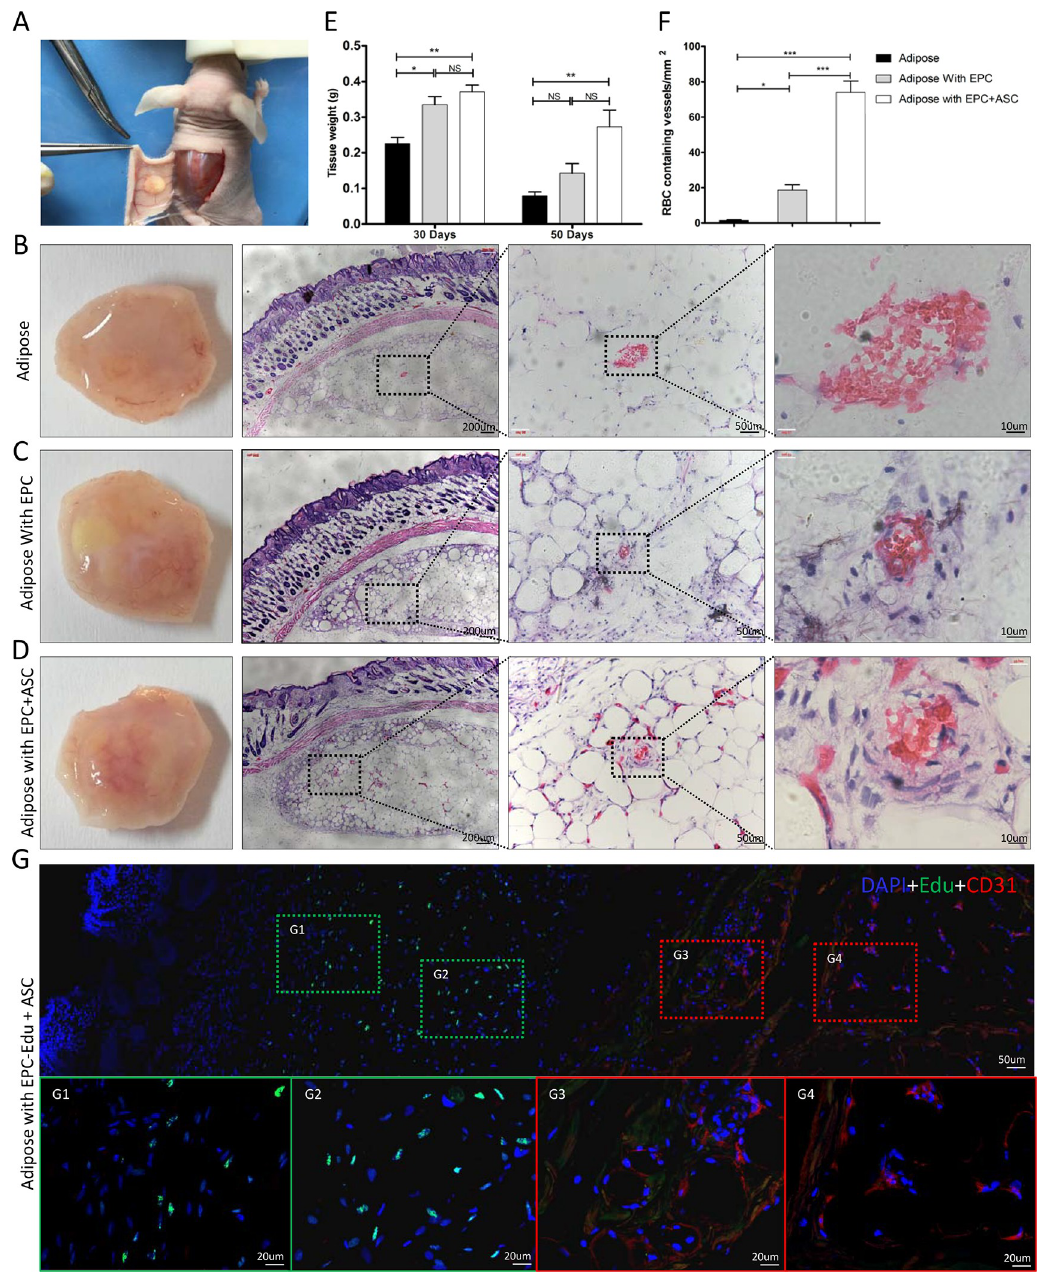
Fig 7. Coimplantation of ASCs with EPCs increases vascular density in adipose grafts. (A) Photograph illustrating the subcutaneous transplantation of adipose tissue in nude mice. In each group, the fat implants were harvested at 30 days postimplatation and stained with HE. (B-D) Representative photographs and images of HE-stained sections of implanted adipose tissue (B), implanted adipose tissue containing EPCs (C), and implants containing a combination of ASCs and EPCs (D). Higher- magnification images of the boxed areas are shown on the right. (E) In another experiment, the fat tissue in all three groups were dissected and weighted. Data are expressed as the mean ± SEM. � , P < 0.05; �� , P < 0.01; NS = not significant. (F) The density of RBC-filled vessels in the implants of each group was analyzed. Data are expressed as mean ± SEM. � , P < 0.05; �� , P < 0.01. (G) Represent images of immunofluorescence staining of Edu labeled EPC and CD31 positive vessels in the adipose implants. The higher magnifications of the boxed areas are shown on the lower panel. CD31 expression was stained in red, Edu labeled EPCs was stained in green, nuclei were stained in blue with DAPI.